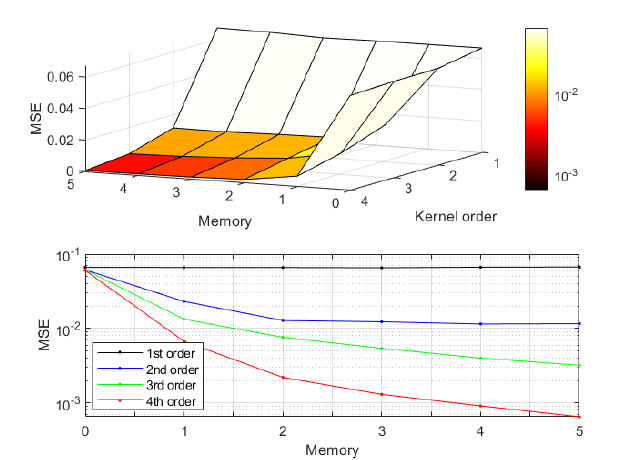
Figure 11. Mean squared error dependence on the memory and on the order of the Volterra system without cross-terms. On the bottom figure, the MSE dependence on the memory is shown at fixed kernel